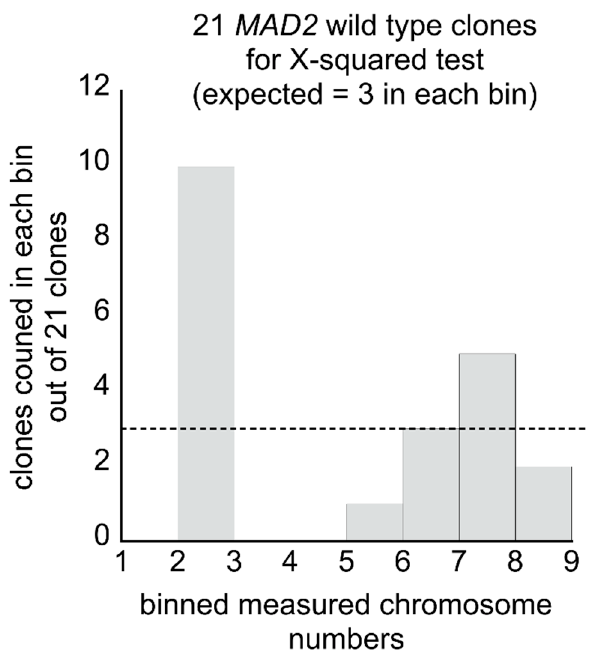
Figure 7. The distribution in average chromosome copy numbers in wild-type MAD2 clones is not likely to be random: The measured average chromosome copy numbers from 21 wild-type MAD2 clones are binned into whole number integers by rounding the measured value up or down. The dashed horizontal line represents the average number of 3 clones expected in each group if there was a random distribution of chromosome copy numbers among clones, which in the Χ -squared test is the null hypothesis.